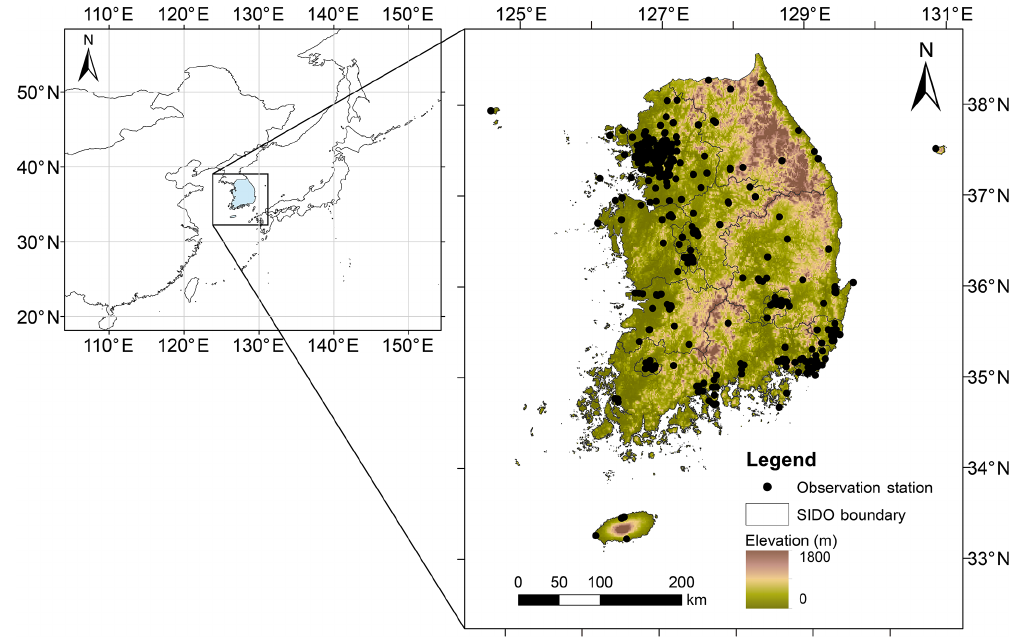
Figure 1. Study area with particulate matter (PM) monitoring station sites in South Korea. Elevation is used as a background